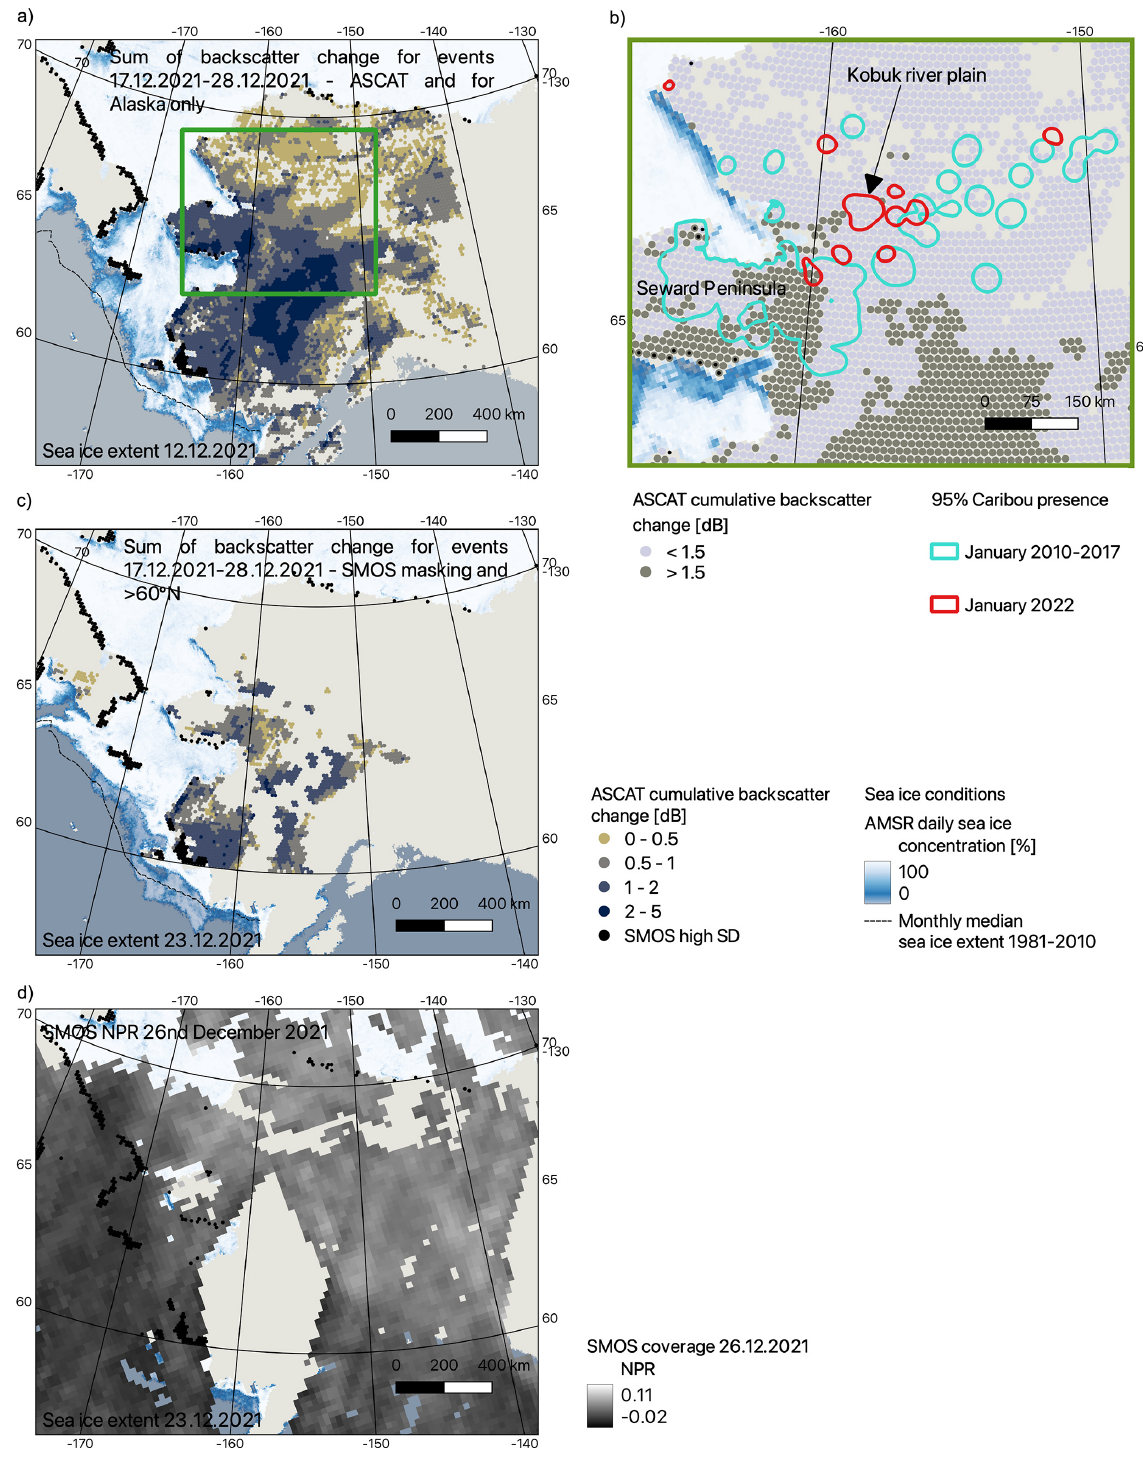
Figure 15. Rain-on-snow event in Alaska in December 2021: (a) cumulative ASCAT (cid:49)σ 0 for both events before masking with SMOS and sea ice extent before the first event; green rectangle – extent of map (c) ; (b) after masking and sea ice extent at the beginning of the second event; (c) separation of cumulative ASCAT (cid:49)σ 0 > 1dB and areas of caribou presence in January 2010–2017 versus 2022; (d) example